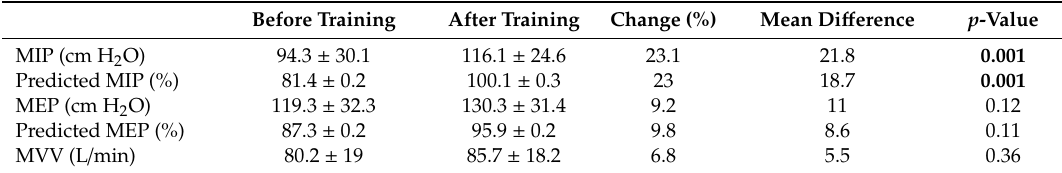
Table 3. Comparison of MIP, MEP, and MVV before and after the program ( n = 15). Expressed as absolute and relative (percentage of predicted values) values. Before Training After Training Before Training